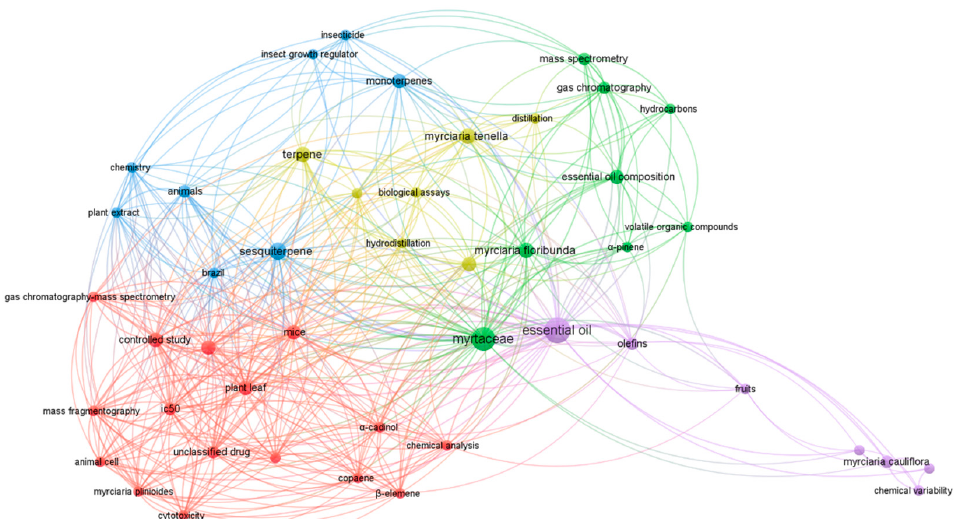
Figure 4. Network map of the most searched keywords and related to the theme, from 2010 to 2021.